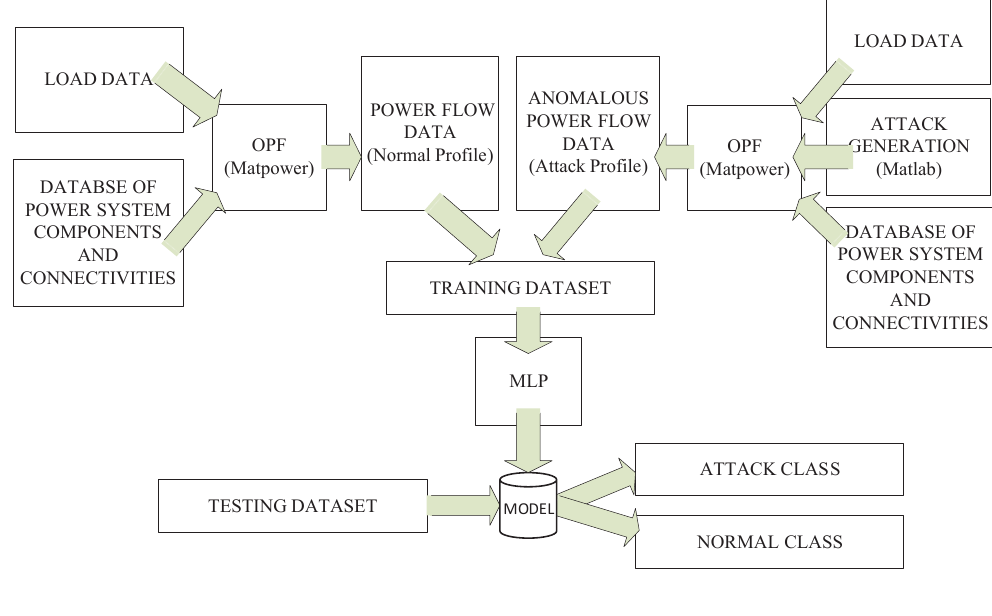
Figure 5. Solution